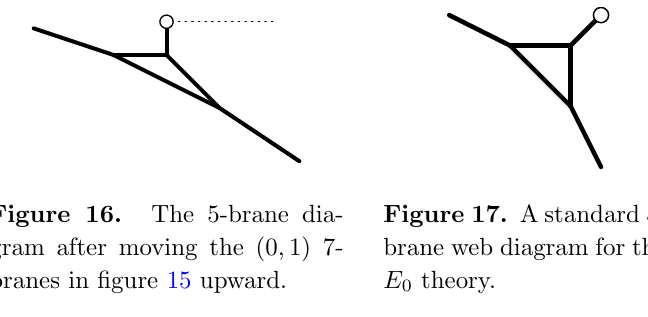
Figure 16. The 5-brane dia- gram after moving the (0 ; 1) 7- branes in (cid:12)gure 15 upward.